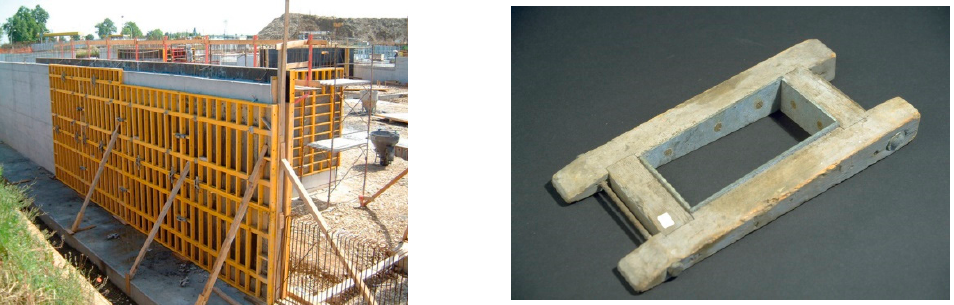
Figure 8. ( a ) Traditional manufacturing as walls manufacturing (Reproduced from [42]) and ( b ) bricks manufacturing (Reproduced from [43]).